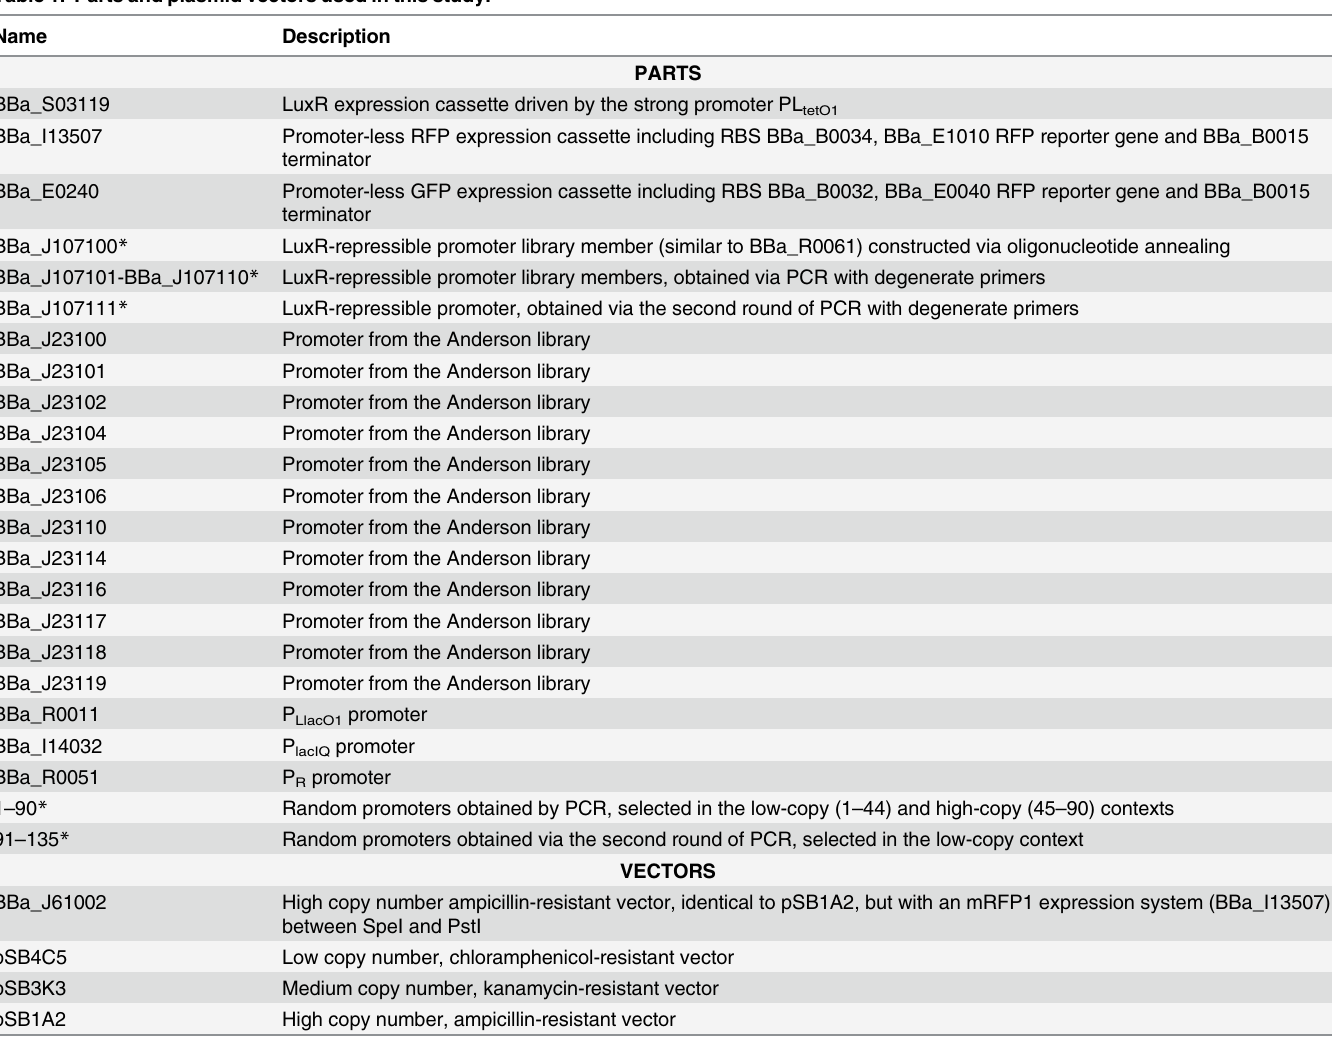
Table 1. Parts and plasmid vectors used in this